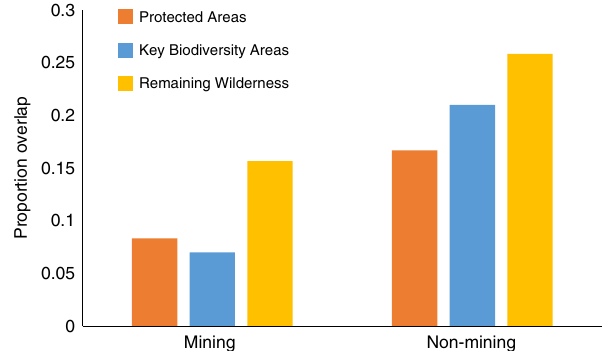
Fig. 2 Overlap between mining and biodiversity conservation. Bars depict the areal proportion of mining and non-mining areas that overlap with currently Protected Areas and conservation priorities (Key Biodiversity Areas and Remaining Wilderness). Mining areas were mapped using a 50- cell radius around known mining properties; non-mining areas include the remaining terrestrial land surface excluding Antarctica. Mining areas overlapped with Protected Areas and conservation priorities signi fi cantly less often than non-mining areas overlapped with Protected Areas and conservation priorities (Protected Areas: n = 2, p < 0.001; Key Biodiversity Areas: n = 2, p = 0.009; Remaining Wilderness: n = 2, p < 0.001). Results hold when comparing areas by mine status (i.e. pre-operating, operating, closed), except for closed regions overlapping with Key Biodiversity Areas, which did not differ signi fi cantly between mining and non-mining areas ( n = 2, p = 0.140). Results also hold when mapping mining areas using a 10- cell radius around mining properties and when sampling the data at 300 km intervals. Note : Graphed proportions were calculated from full extent of mining and non-mining areas, whereas reported statistics were calculated using the 1 km 2 cells sampled at 100-cell